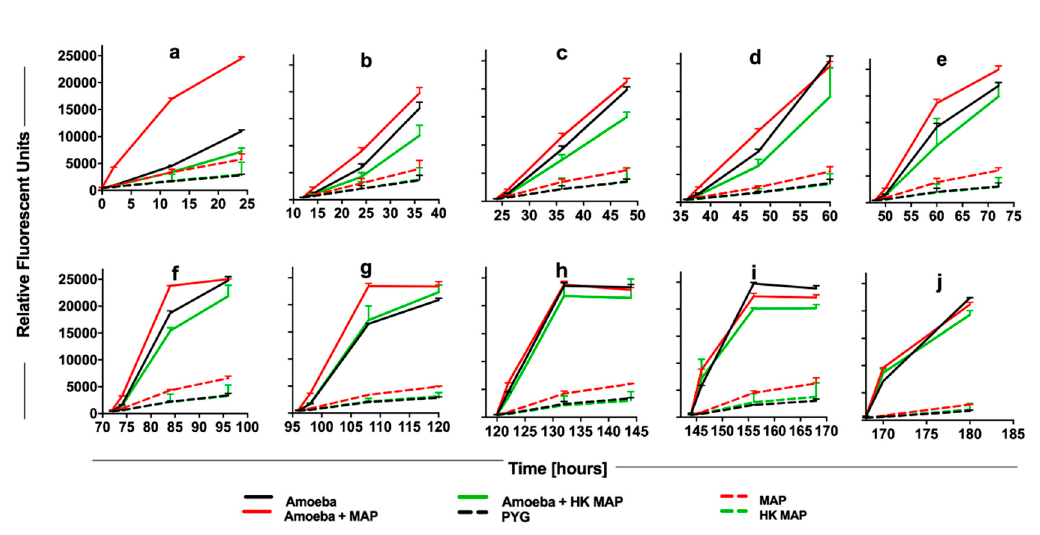
Table 2. List of genes interrupted in MAP mutants.